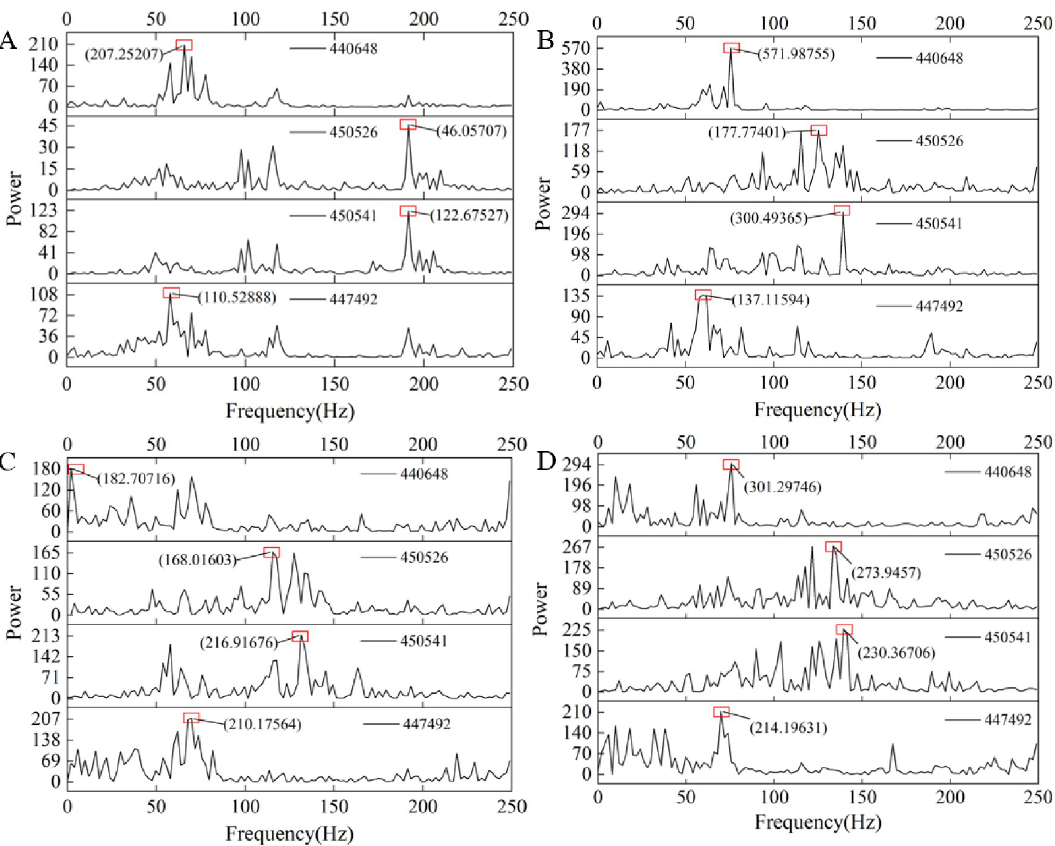
Fig 14. The power spectrum of four nodes with different gangue content. (A) The gangue content of 0%. (B) The gangue content of 25%. (C) The gangue content of 50%. (D) The gangue content of 75%.